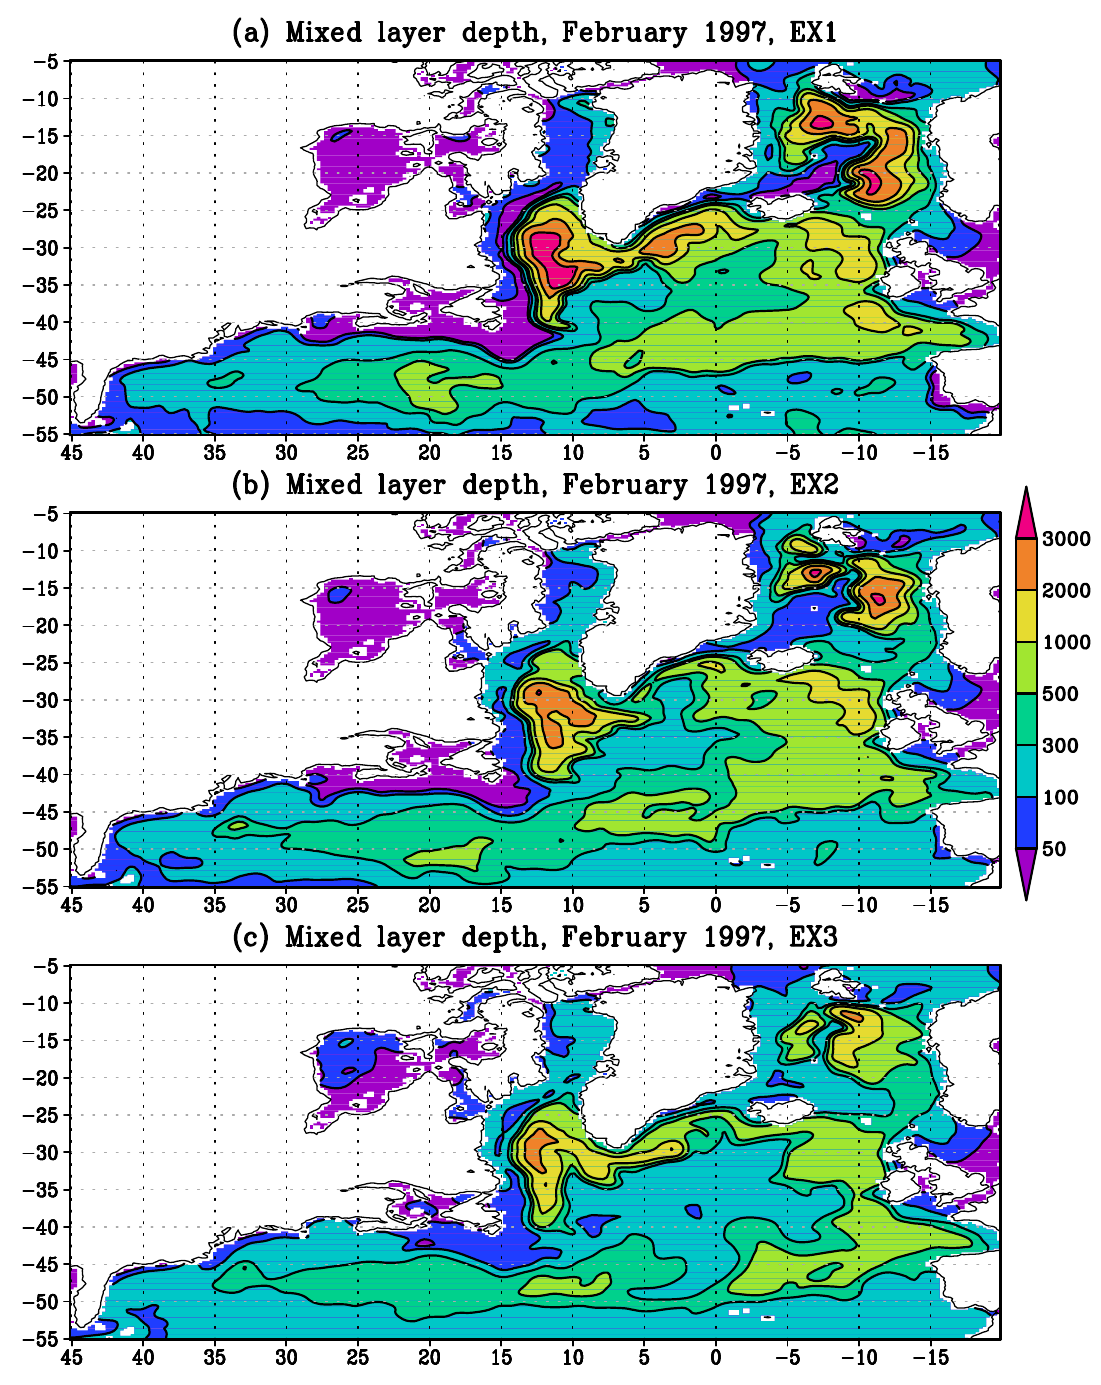
Figure 6. Maximum thickness of the upper mixed layer (in meters) for the 50th year of integration (February 1997) in the EX1 ( a ), EX2 ( b ), EX3 ( c ) in model coordinates. Ocean currents. Changes in the fields of temperature, salinity and density associated with the change in the mixing parameterization cover almost the entire upper half of the baroclinic layer (Figures 3–5). This causes a high sensitivity of the circulation and SSH to the change of